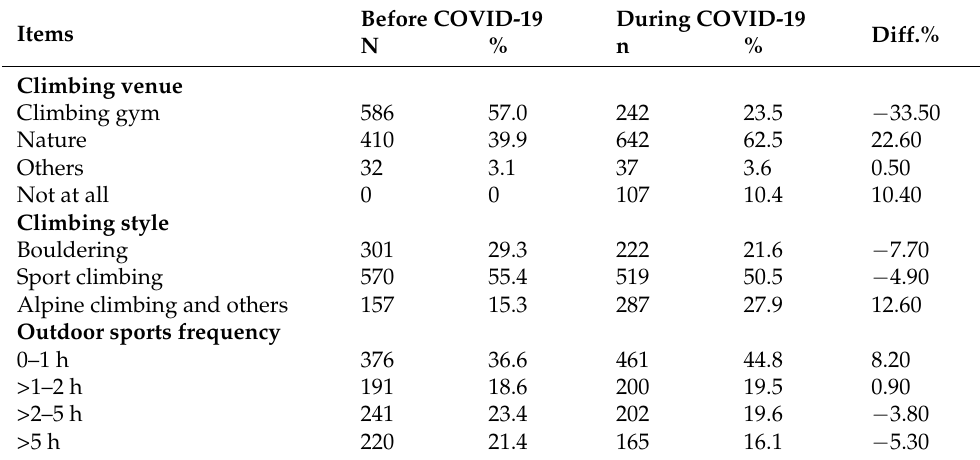
Table 3. Responses to items related to climbing (single choice on most applicable climbing venue, climbing style, and outdoor sports frequency) before and during the COVID-19 pandemic.